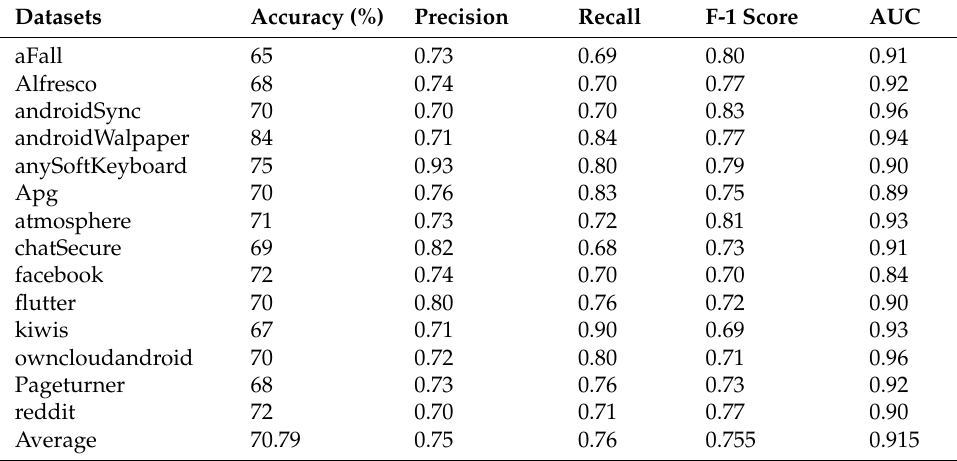
Table 2. ANN defect prediction results (within-project